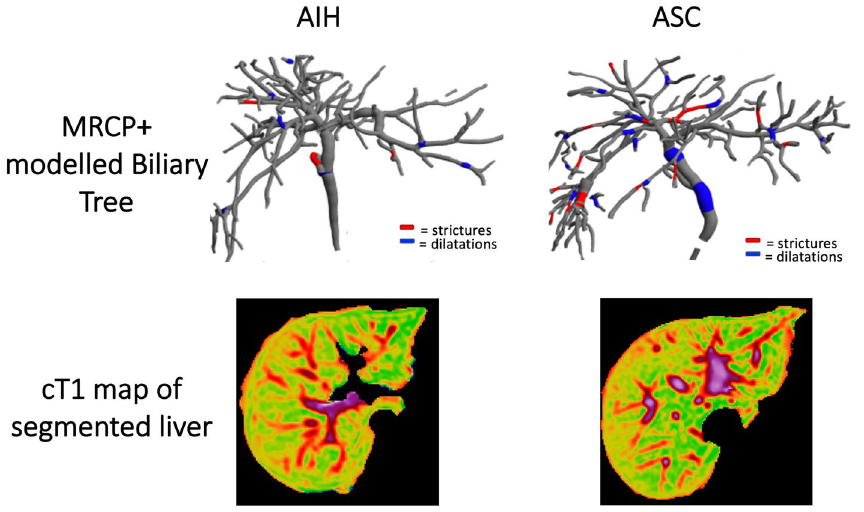
Figure 1. Representative biliary tree models and cT1 maps from an AIH patient (left) and an ASC patient (right). For the ASC patients, the MRCP + model shows the presence of multiple strictures (red) and dilatations